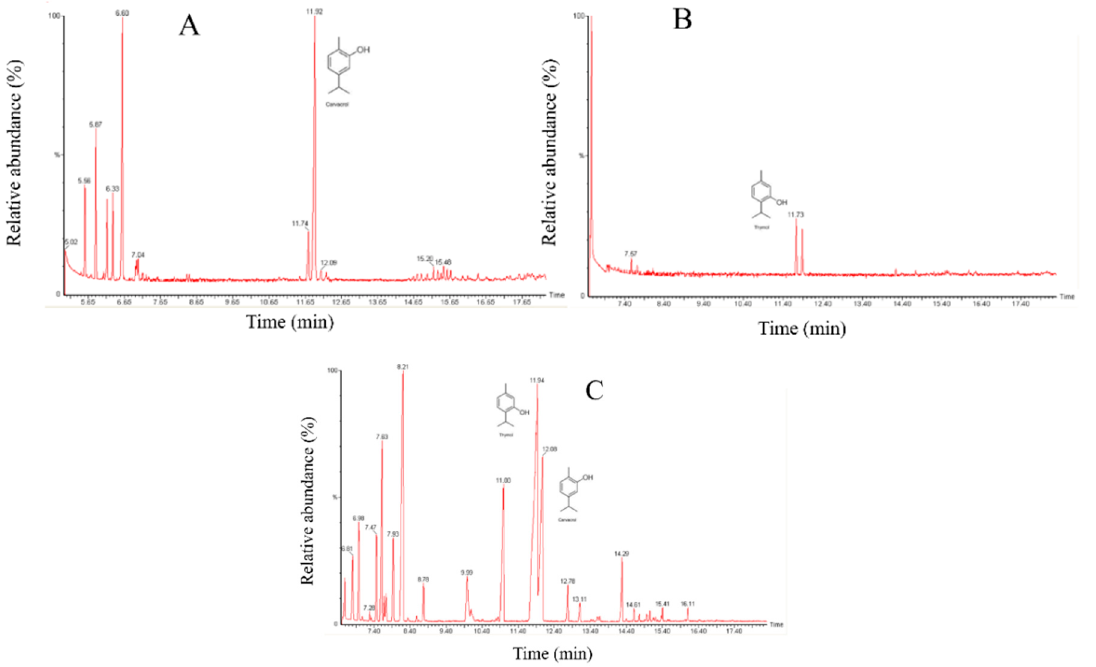
Figure 3. Gas-Chromatography chromatogram of Mexican oregano essential oils. ( A ) . Lippia berlandieri Schauer with a higher proportion of carvacrol (EO1). ( B ). Lippia berlandieri Schauer with higher proportion of thymol (EO2). ( C ). Poliomintha longiflora , with a higher proportion of thymol.